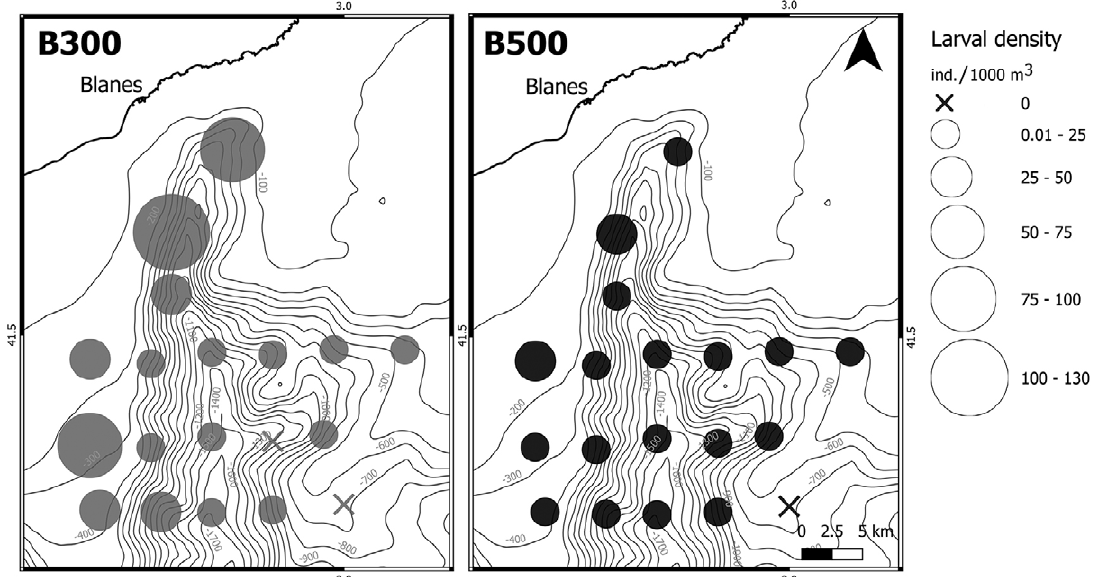
Fig. 3. – Density of early (B300, stages I to III) and late (B500, stages VI to decapodid) larval stages of all decapod larvae in individuals (ind.) per 1000 m 3 .